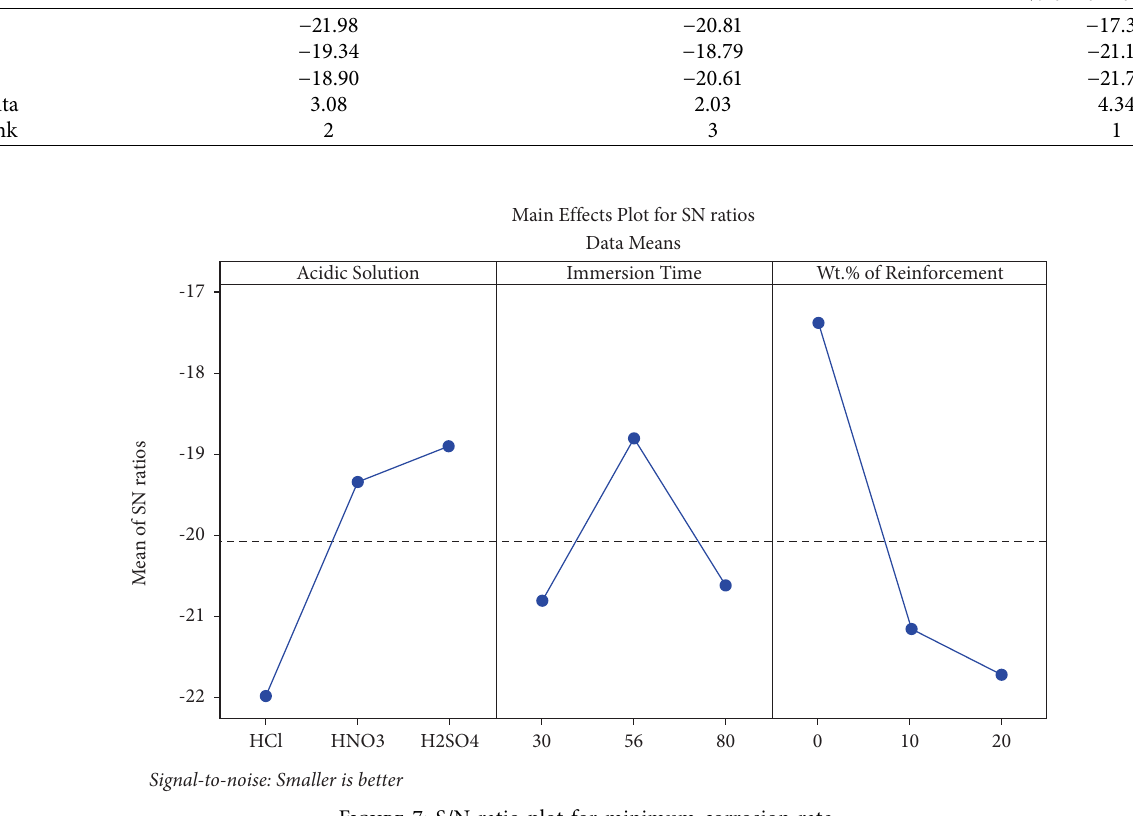
Figure 7: S/N ratio plot for minimum corrosion rate.